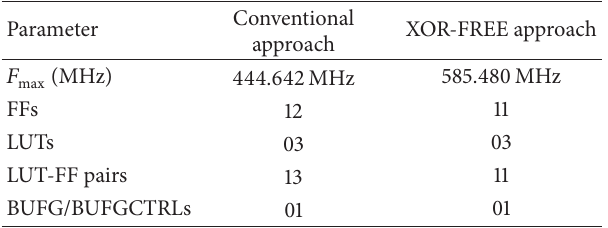
Table 8: Resource utilization comparison for the